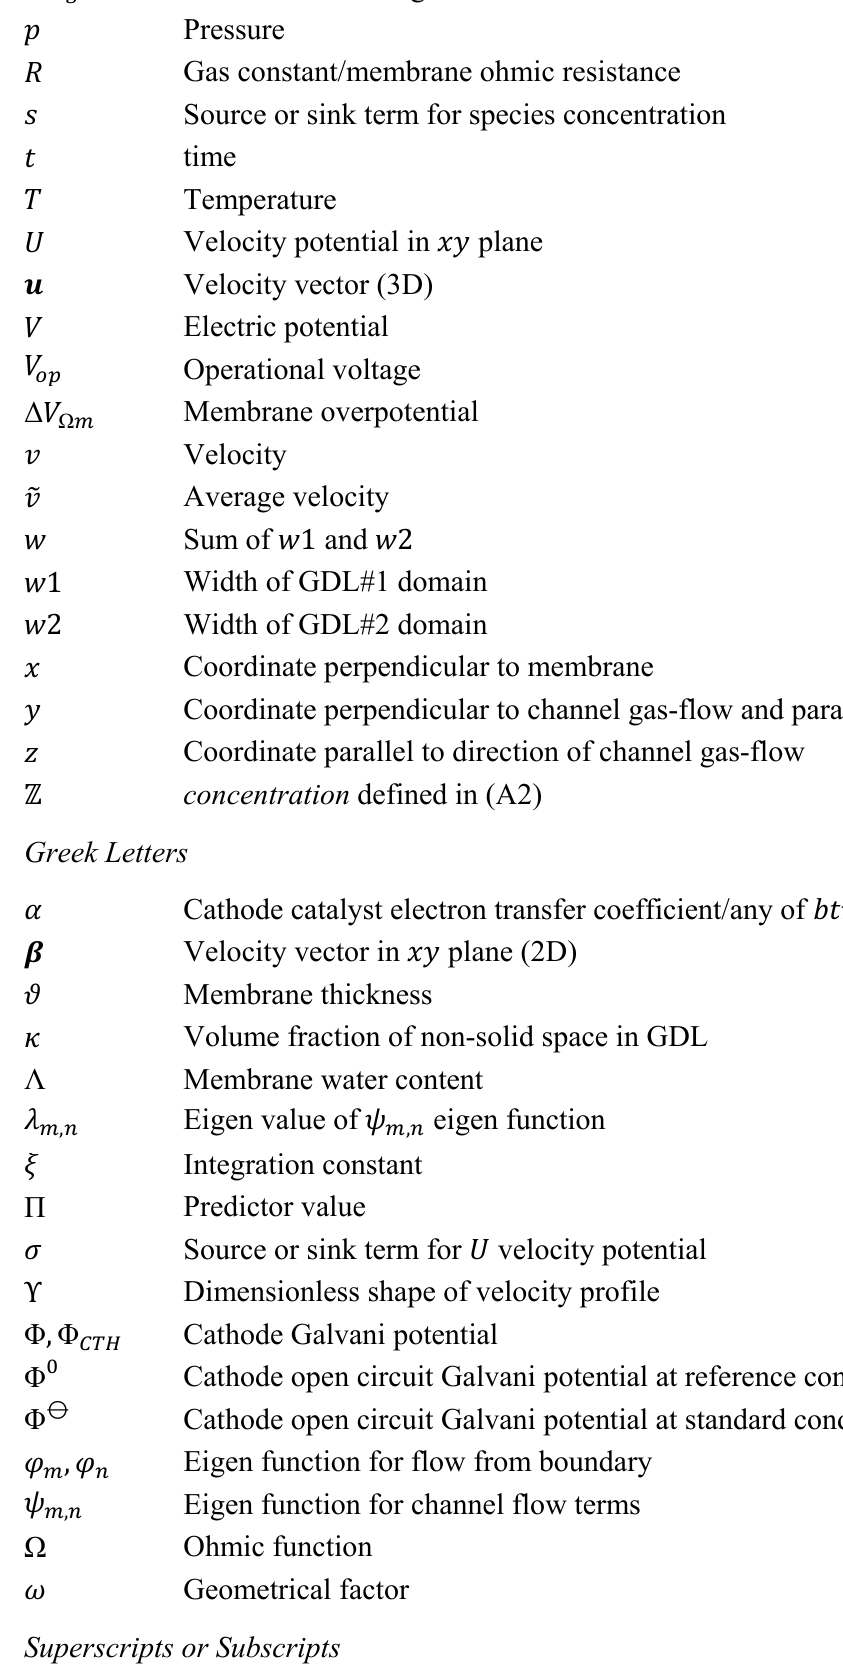
Electroosmotic drag